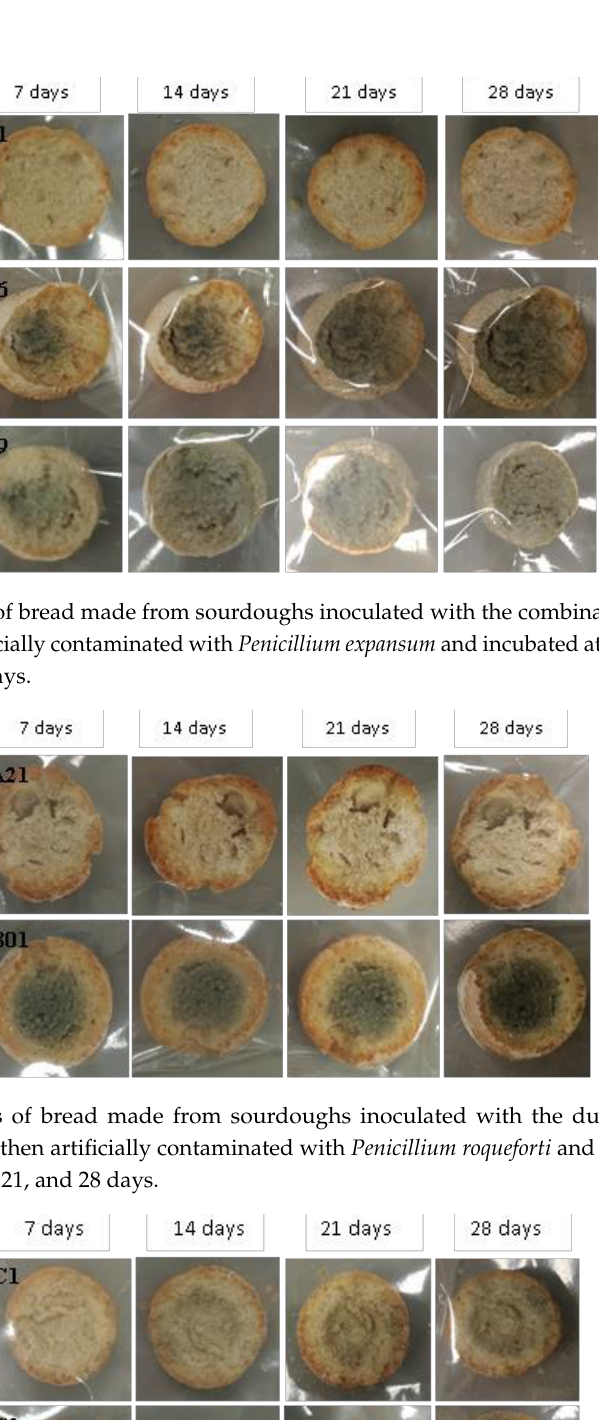
A10 and A09, then artificially contaminated with Penicillium expansum and incubated at room